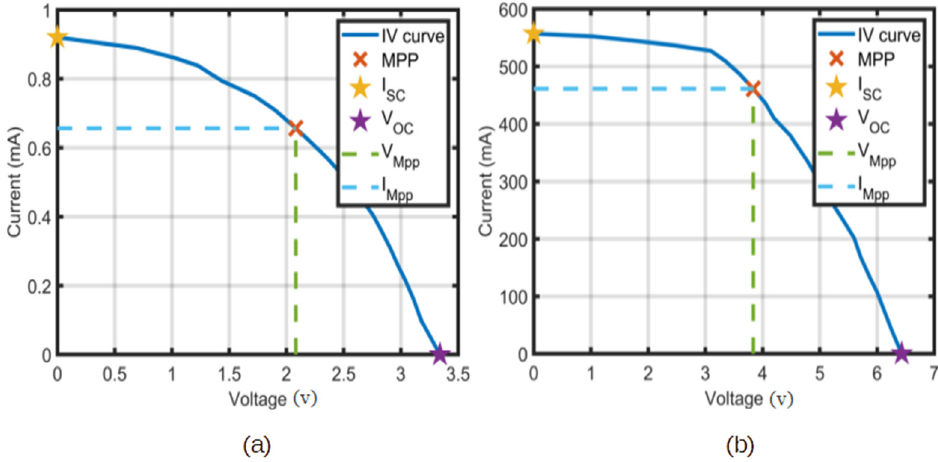
7 of 21 Figure 10. The measured relation between the luminance and the generated open-circuit voltage.